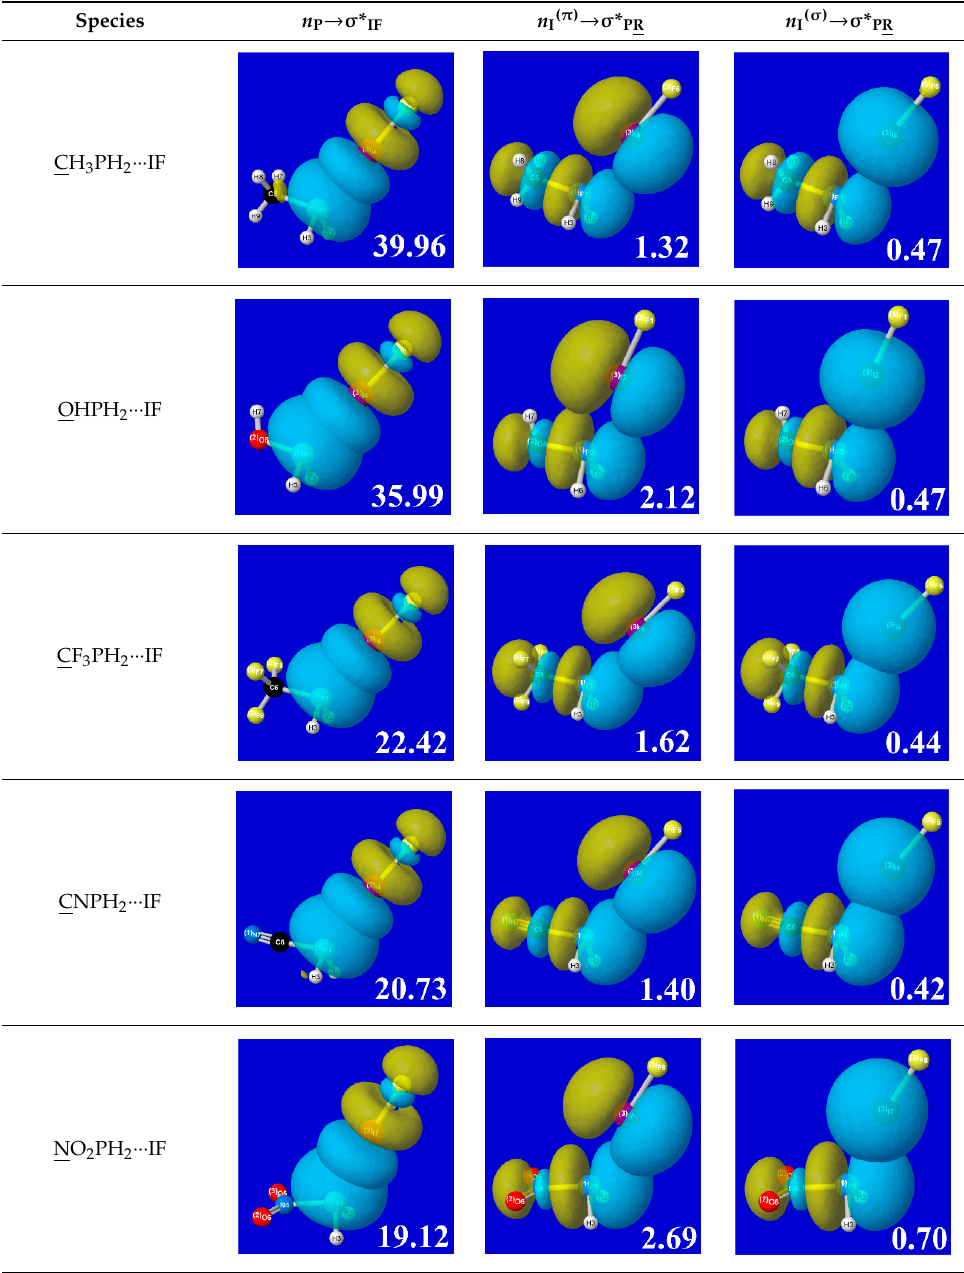
Table 4. “Pre-orthogonal” natural bond orbital (PNBO) orbital overlap diagrams (with perturbative Δ E (2)n σ * stabilization energy (kcal/mol) as inset) for RPH 2 ···IF complexes (cf. Table 3), showing the usefulness of Mulliken-type orbital overlap visualizations in “guesstimating” donor–acceptor